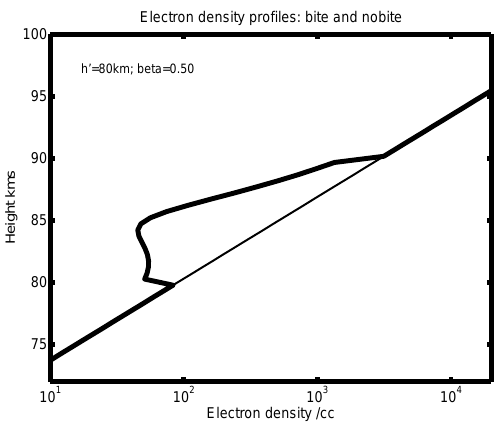
Fig. 1. Plot of ambient electron density profile and perturbed profile showing